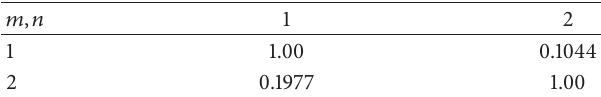
Table 6: Correlation matrix for OLT (lower/upper triangular part: amplitude/phase).